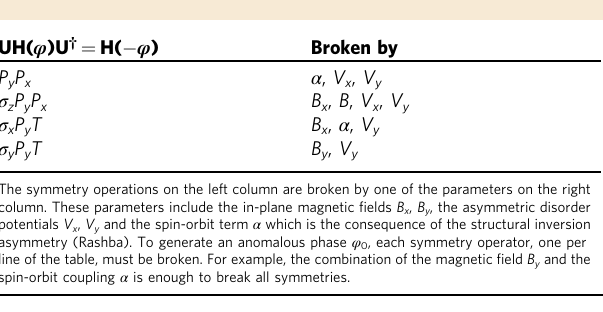
Table 1 Symmetry operations U protecting H( φ ) = H( − φ ) from ref. 3